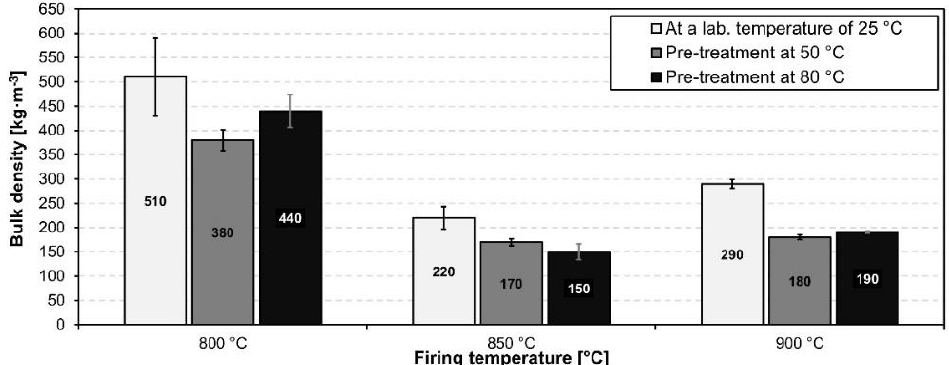
Figure 9. Bulk density of prepared foam samples fired at different temperatures.